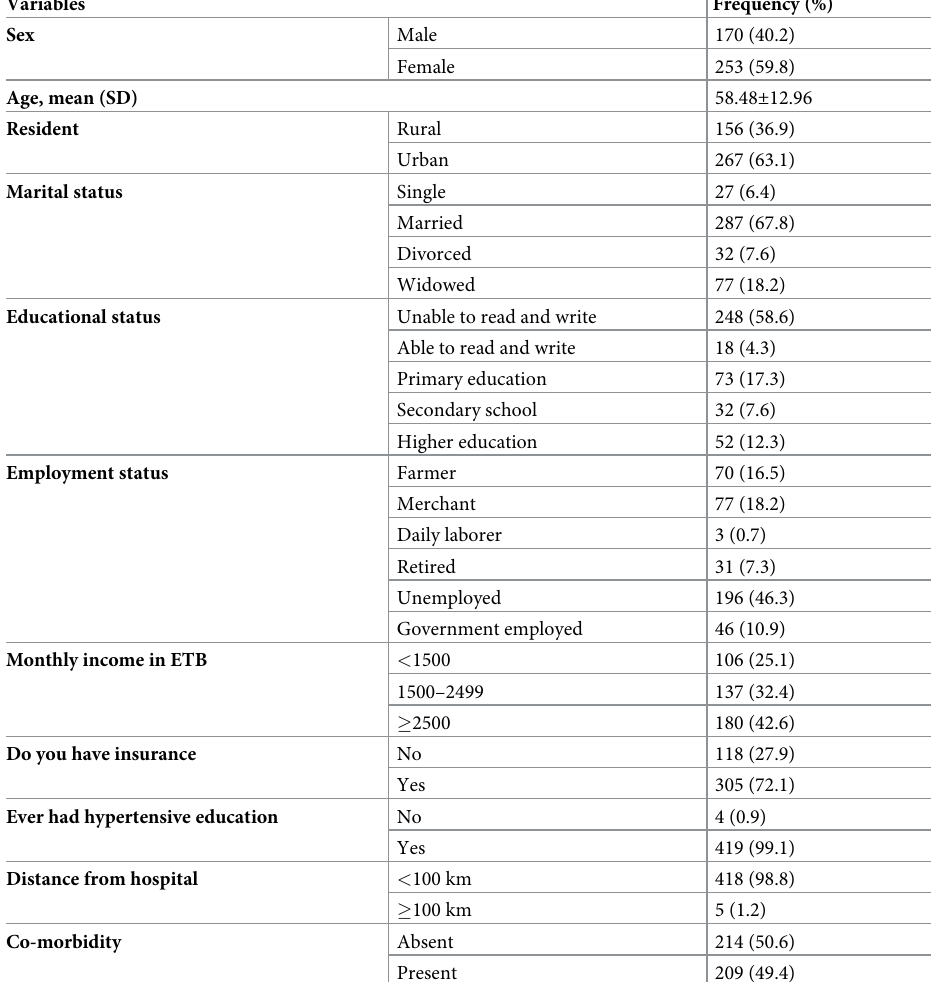
Table 1. Socio-demographic and clinical characteristics of the study participants (N =